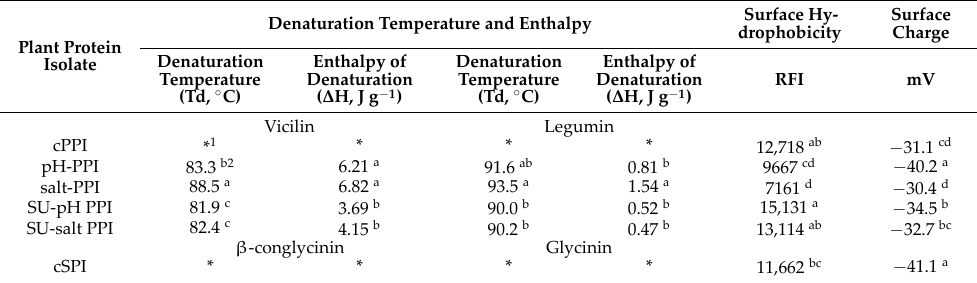
Table 3. Denaturation temperatures and enthalpy, surface hydrophobicity and surface charge of commercial protein references and the different PPI samples produced at bench scale and pilot